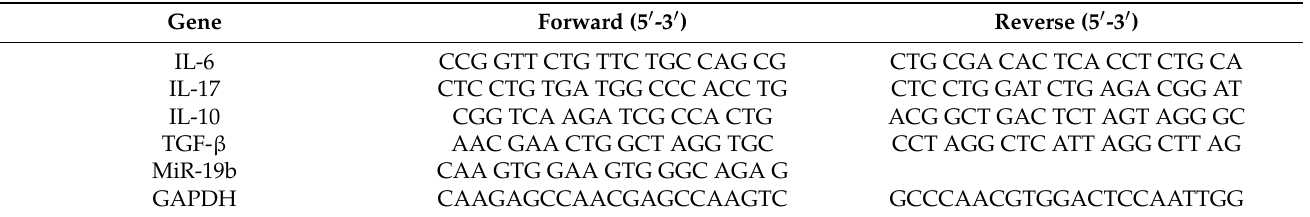
Table 1. Sequences of primers